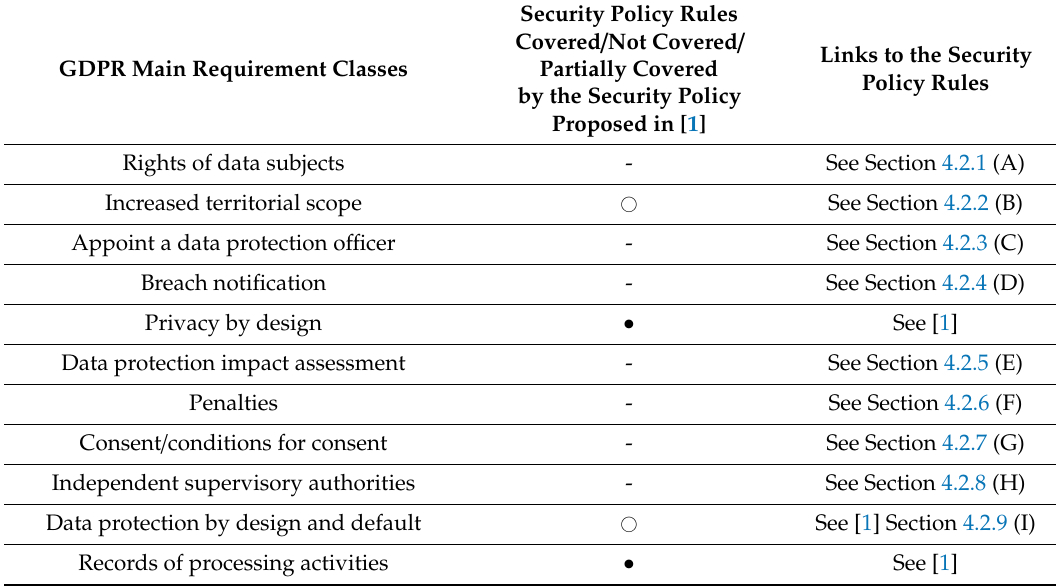
Table 2. Enhancement to the cloud-based security policy in order to be GDPR